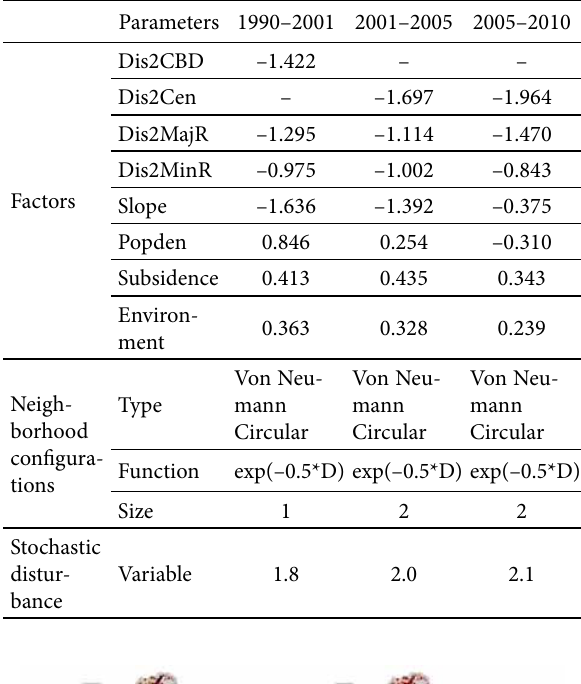
Table 1. Calibration results of the CA model during 1990–2001,